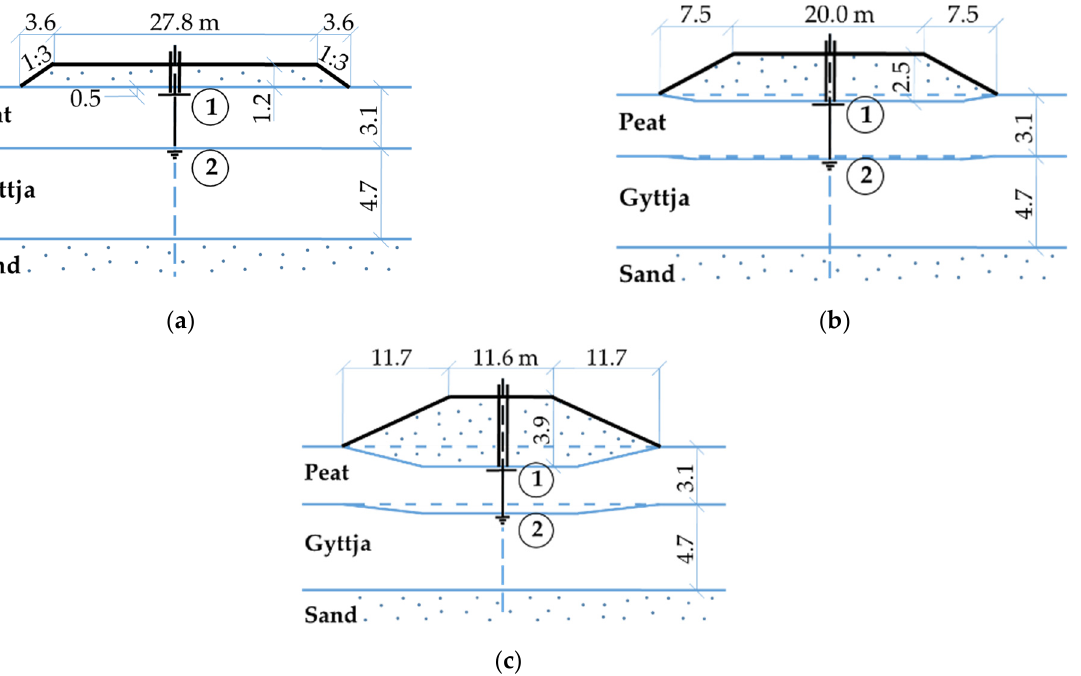
Figure 2. Test embankment at the Antoniny site: ( a ) 1st stage, ( b ) 2nd stage, ( c ) 3rd stage, 1–surface settlement gauge, and 2–deep settlement gauge.